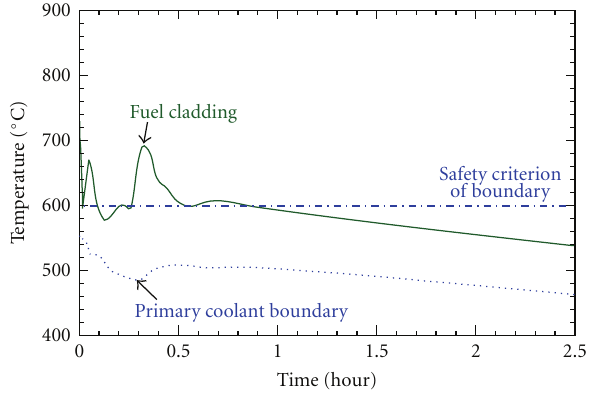
Figure 7: Loss-of-o ff site power event (long term).